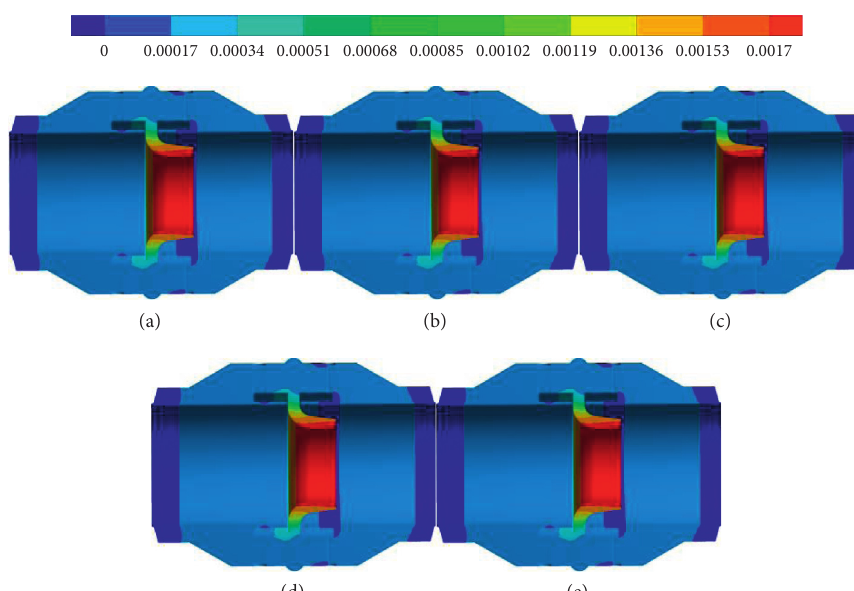
Figure 17: Deformation distribution in the section of fluid excitation (10 m 3 /h). (a) 50 ° C. (b) 100 ° C. (c) 300 ° C. (d) 500 ° C. (e) 700 ° C.